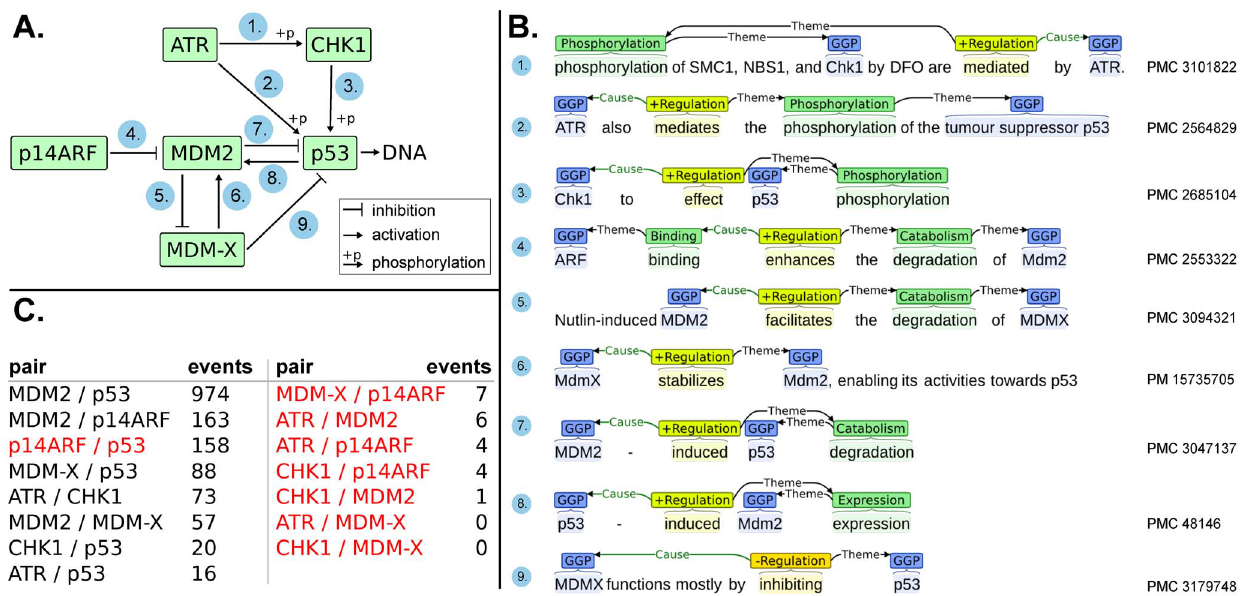
Figure 5. Events mapped to biomolecular pathways from KEGG. A) Close interactions of p53 from KEGG pathway hsa04115. B) The highest confidence predicted event from EVEX for each directed KEGG association. All are correct and correspond to the KEGG interaction type. Event visualizations were made with stav [27]. C) The number of events in the text mining dataset for each undirected protein pair. Pairs not corresponding to a direct molecular interaction in A) are shown in